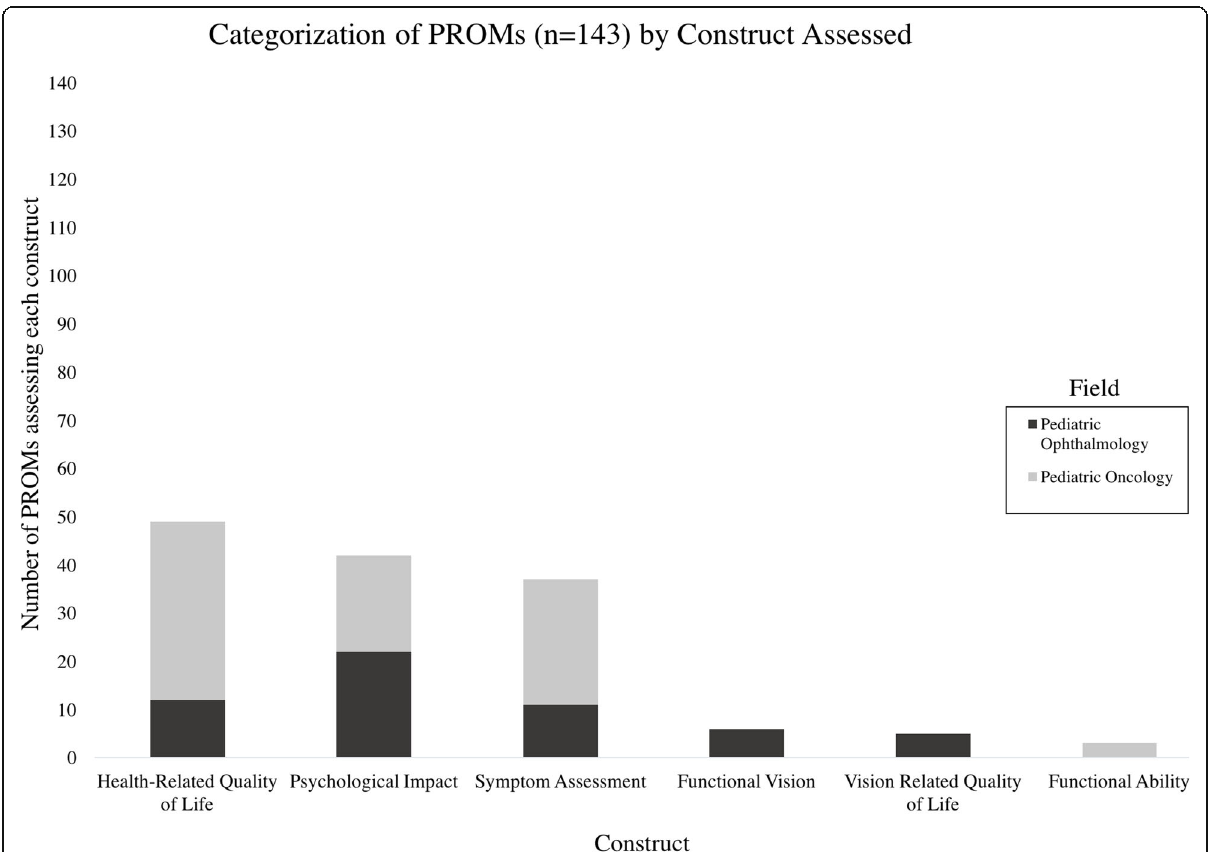
Fig. 3 Categorization of PROMs by Construct Assessed. The PROMs identified in the scoping review (n = 143) were characterized by construct. Constructs, shown left to right, are ordered most frequently assessed to least frequently assessed. The most frequently assessed domains was ‘ HRQoL ’ (49/143) followed by ‘ Psychological Impact ’ (42/143), and ‘ Symptom Assessment ’